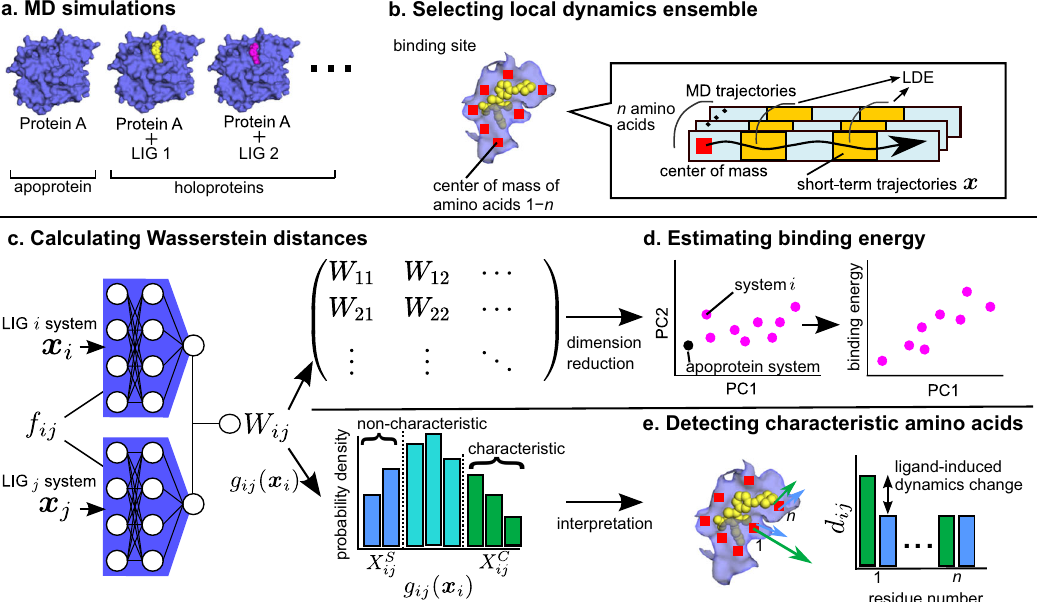
Fig. 1 Work fl ow to detect differences in ligand-induced protein dynamics. a Molecular dynamics (MD) simulations for ligand-free (apoprotein) and ligand-bound (holoprotein) systems. b Ligand-induced protein dynamics is represented by local dynamics ensemble (LDE), which is an ensemble of short- term trajectories x of the center of mass of n binding-site residues. c The difference of the LDEs between system i and j is calculated based on Wasserstein distance W ij using deep neural networks (DNNs) f ij . The Wasserstein distances are calculated for all pairs of systems and the distance matrix is obtained. In addition, each short-term trajectory in system i is represented by the output of the DNNs which is denoted as a function g ij ( x i ). In histogram bottom, high g ij ( x i ) (green) and low g ij ( x i ) (blue) indicate that the short-term trajectories are characteristic to system i and similar to system j , e.g., characteristic to apoprotein and similar to holoprotein, respectively. d The matrix of Wasserstein distances is embedded into points in a lower-dimensional space, and principle component analysis is performed to the embedded points. The fi rst principal component (PC1) is compared to ligand-binding energies. e The difference detected by g ij ( x i ) is interpreted, and the residues whose dynamics are changed by ligand interactions are examined. For the characteristic and non-characteristic trajectories, short-term mean square displacement (RMSD) d ij is calculated per residue. If the large gaps of d ij are observed between the characteristic and non-characteristic trajectories, the residues are highly in fl uenced by the